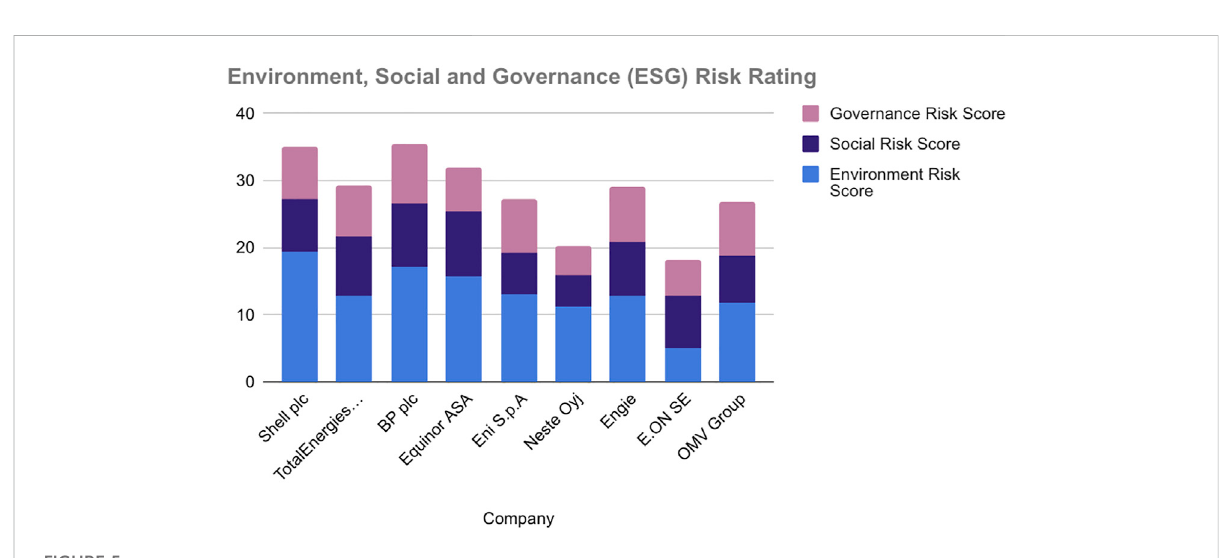
FIGURE 5 Stacked ESG column chart. Source: Sustainalytics,